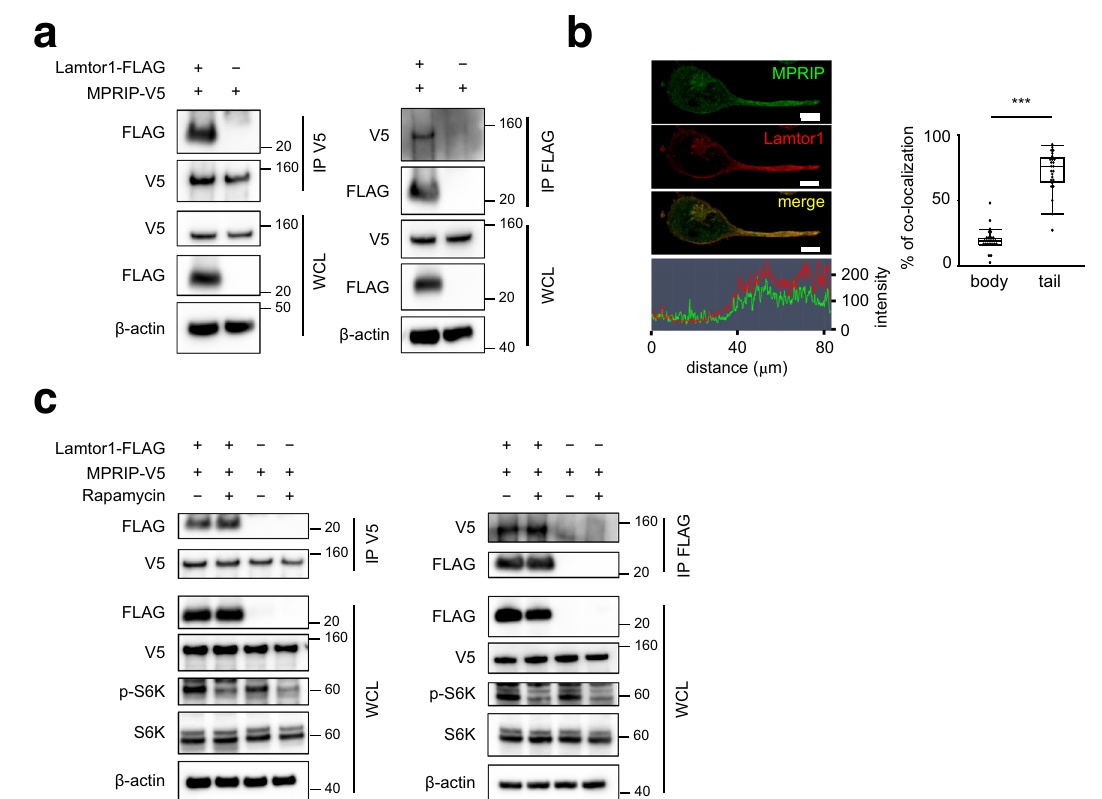
Fig. 4 Lamtor1 interacts with MPRIP independently of mTORC1. a Interacting of Lamtor1 and MPRIP. FLAG-tagged Lamtor1 expression vector or control vector was transfected into V5-tagged-MPRIP-expressing HEK293T cells. Cells were lysed, precipitated with anti-V5 antibody (left) or anti-FLAG antibody (right), and detected by western blotting with anti-V5 and -FLAG antibodies. Whole-cell lysates (WCL) were detected with anti- β -actin antibody. Data are representative of three experiments. b Co-localization of Lamtor1 and MPRIP. Localization of MPRIP in Lamtor1-FLAG-expressing THP1 was evaluated by confocal microscopy using anti-MPRIP and anti-FLAG antibodies. A representative image of MPRIP (green) and Lamtor1 (red) in a polarized cell is shown. Scale bar, 10 μ m (upper), and the intensity of MPRIP (green) and Lamtor1 (red) signals (bottom) (left). Percentage of co-localization of Lamtor1 and MPRIP in the body or tail region of polarized cells ( n = 40) (right). c Lamtor1 interacts with MPRIP independent of mTORC1. Forty-eight hours after transfection of FLAG-Lamtor1 expression vector or control vector into V5-MPRIP-expressing HEK293T cells, the cells were treated with 10 nM rapamycin for 2 h. The lysates were precipitated with anti-V5 (left) or anti-FLAG antibody (right), and the immunoprecipitates were subjected to western blotting with anti-V5 and -FLAG antibodies. WCL was blotted with anti- β -actin, anti-S6K, and anti-phospho-S6K antibodies. Data are representative of three experiments. Statistical analyses were performed by two-sided Mann – Whitney U test ( b ) [median; 25th and 75th percentiles; and minimum and maximum of a population excluding outliers; *** p <